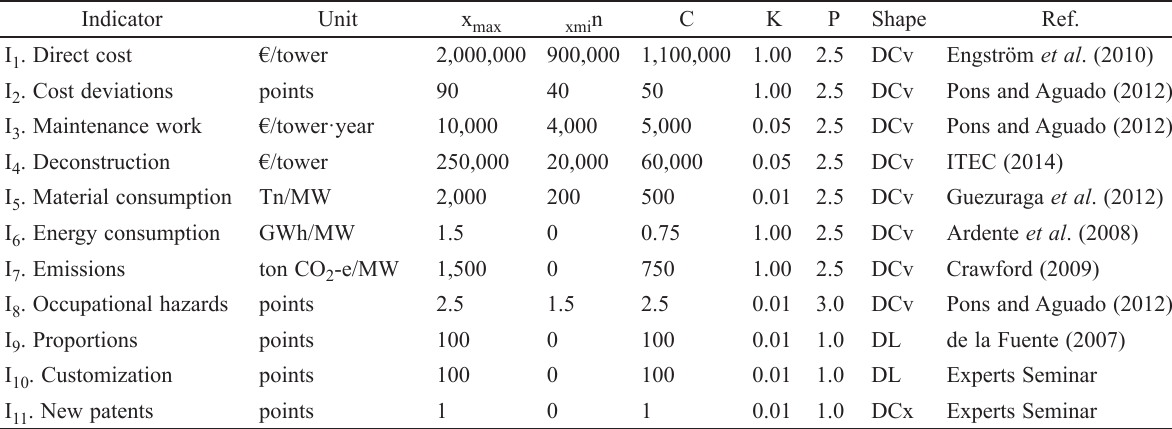
Table 4. Value function parameters for each indicator